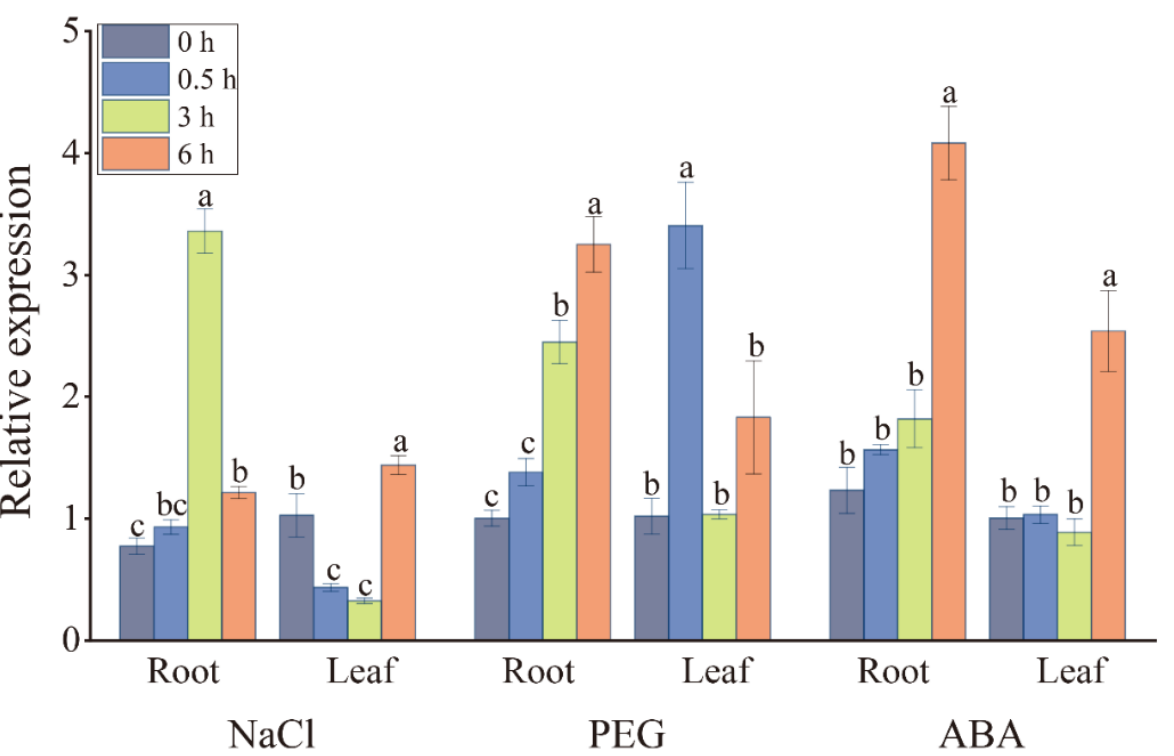
Figure 3. Expression of the ScDREB2B-1 gene in sugarcane hybrid ROC22 under sodium chloride (NaCl), polyethylene glycol (PEG) 8000 and abscisic acid (ABA) treatments by RT-qPCR analysis. Quantitative data were normalized by the expression level of double references of CAC (clathrin adaptor complex) and CUL (cullin) genes. All expression data points were means ± standard error ( n = 3). Significant differences were found between different letter substitutes on the column calculated by Duncan’s new multiple range test ( p -value < 0.05). 2.3. The Promoter of ScDREB2B-1 Was Rich in Cis-Acting Elements Related to Stress and the Expression of Its Homologous Gene in S. spontaneum Could Also Be Induced by Drought Stress